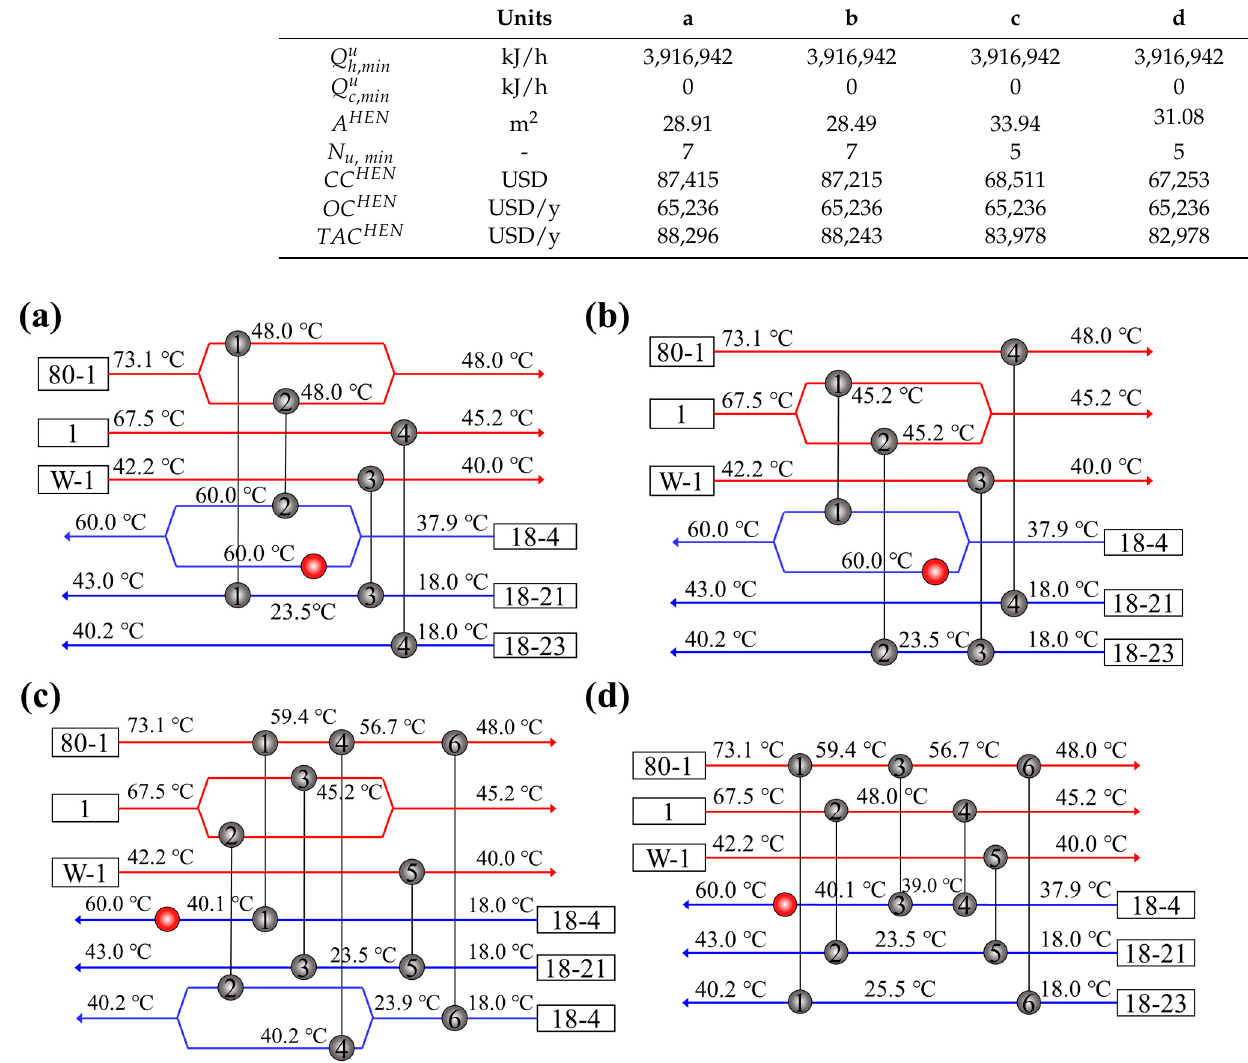
Table 4. Results of HEN retrofitting.